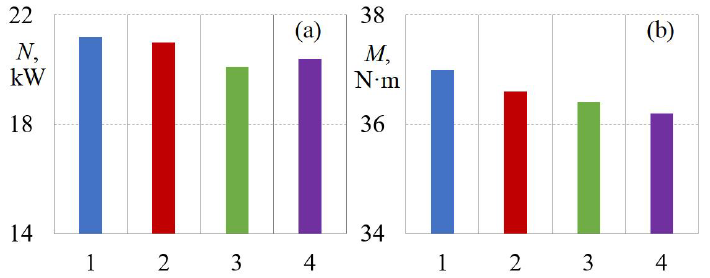
Figure 14. Diagrams of nominal power N ( a ) at n = 5600 rpm and maximum torque M ( b ) at n = 4000 rpm for an intake system with channels of different diameters: 1— d = 20 mm; 2— d = 32 mm; 3— d = 40 mm; 4— d = 50 mm.